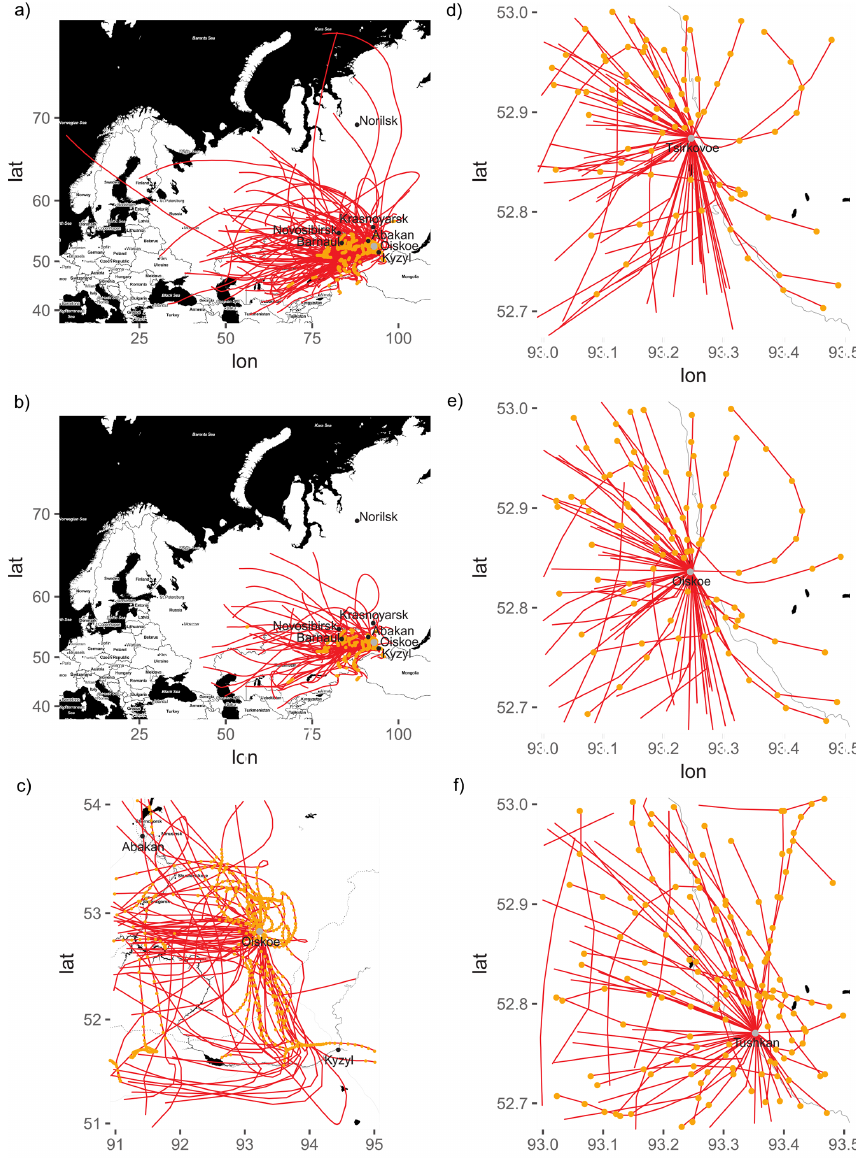
Figure 5. Daily 3d long air mass retro-trajectories flowing onto Lake Oiskoe from 1 October 2016 to 5 April 2017 (a) . Only retro-trajectories of air masses causing precipitation at Lake Oiskoe at different zooms (b, c, e) and at Lake Tsirkovoe (d) and at Tushkan (f) . Yellow dots represent hourly records where the air mass retro-trajectories contacted Earth’s crust. Water bodies are in black. Gray lines are either political borders or the road. Sources: map tiles by Stamen Design, under CC BY 3.0. Data by © OpenStreetMap contributors 2014, distributed